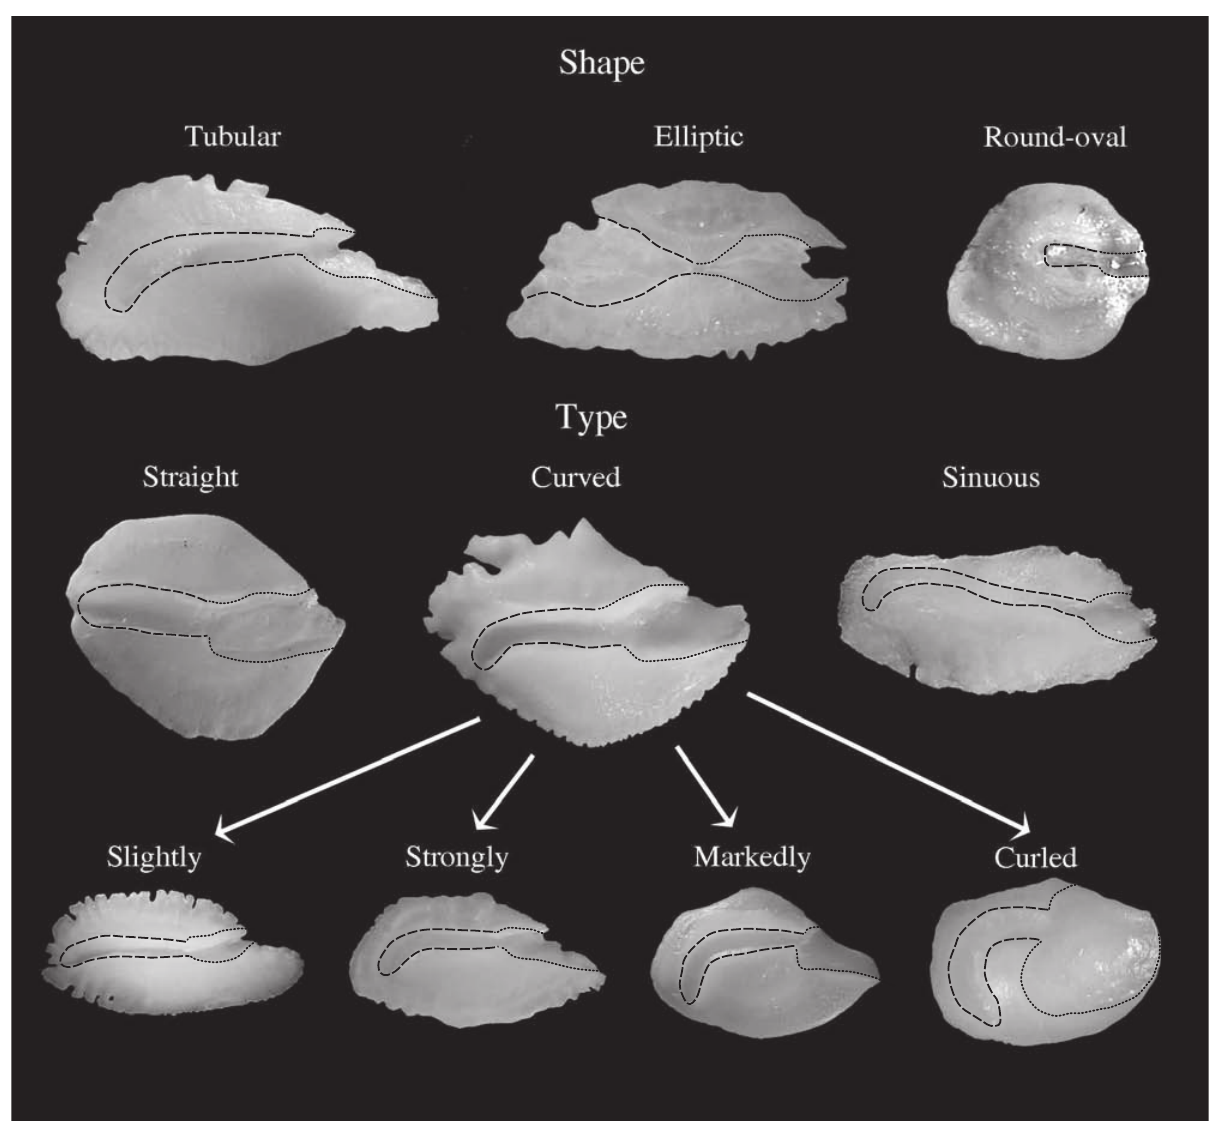
Fig. 7. – Different types of cauda, depending on shape and curvature (cauda limited by a discontinuous line; ostium limited by a dashed